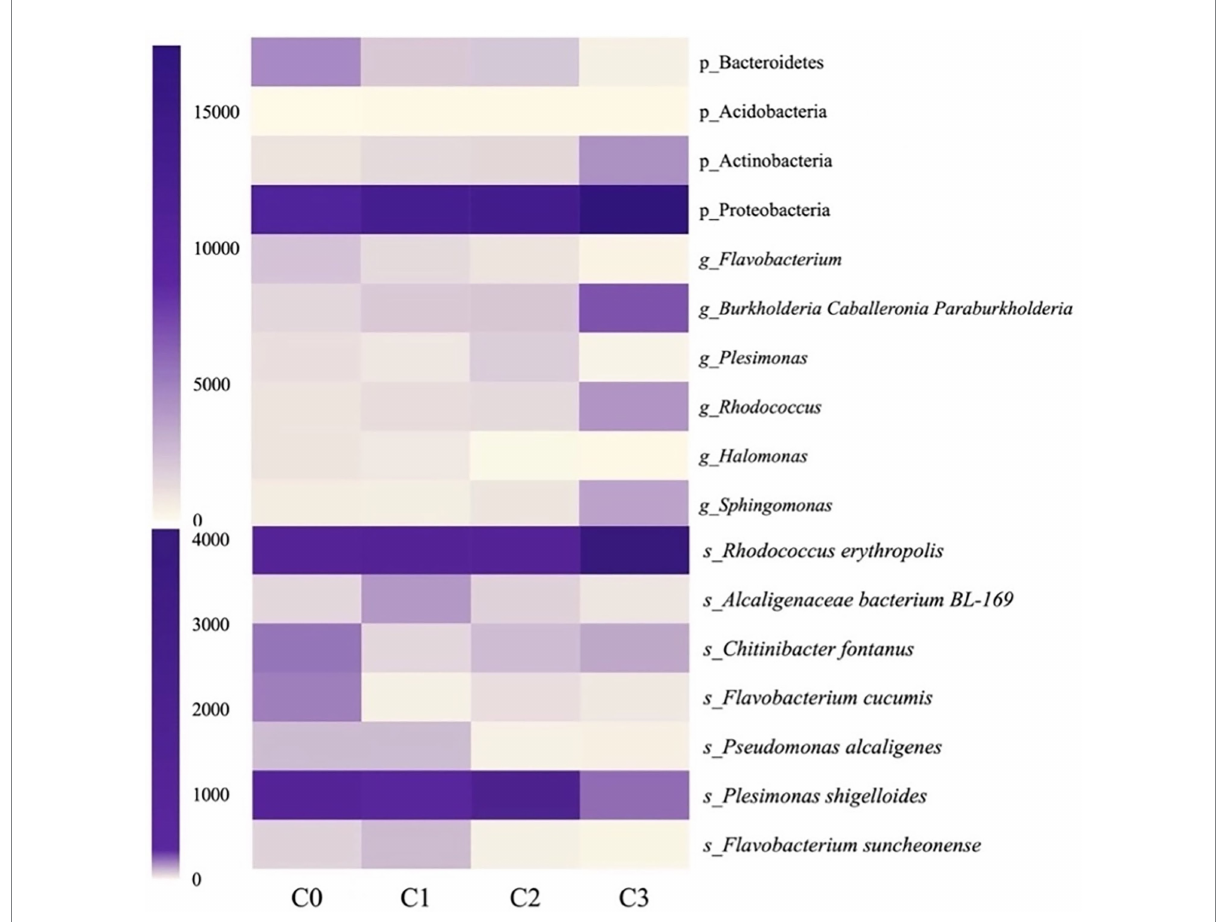
FIGURE 9 Heatmap analysis of the identified bacteria with significant changes after AVH-AgNPs treatment. C0, C1, C2, and C3 indicate AVH-AgNPs treatments with concentrations of 0, 6, 9, and 18 μ g/l, respectively. P_, g_, and s_ represent classifications at phylum, genus, and species levels,